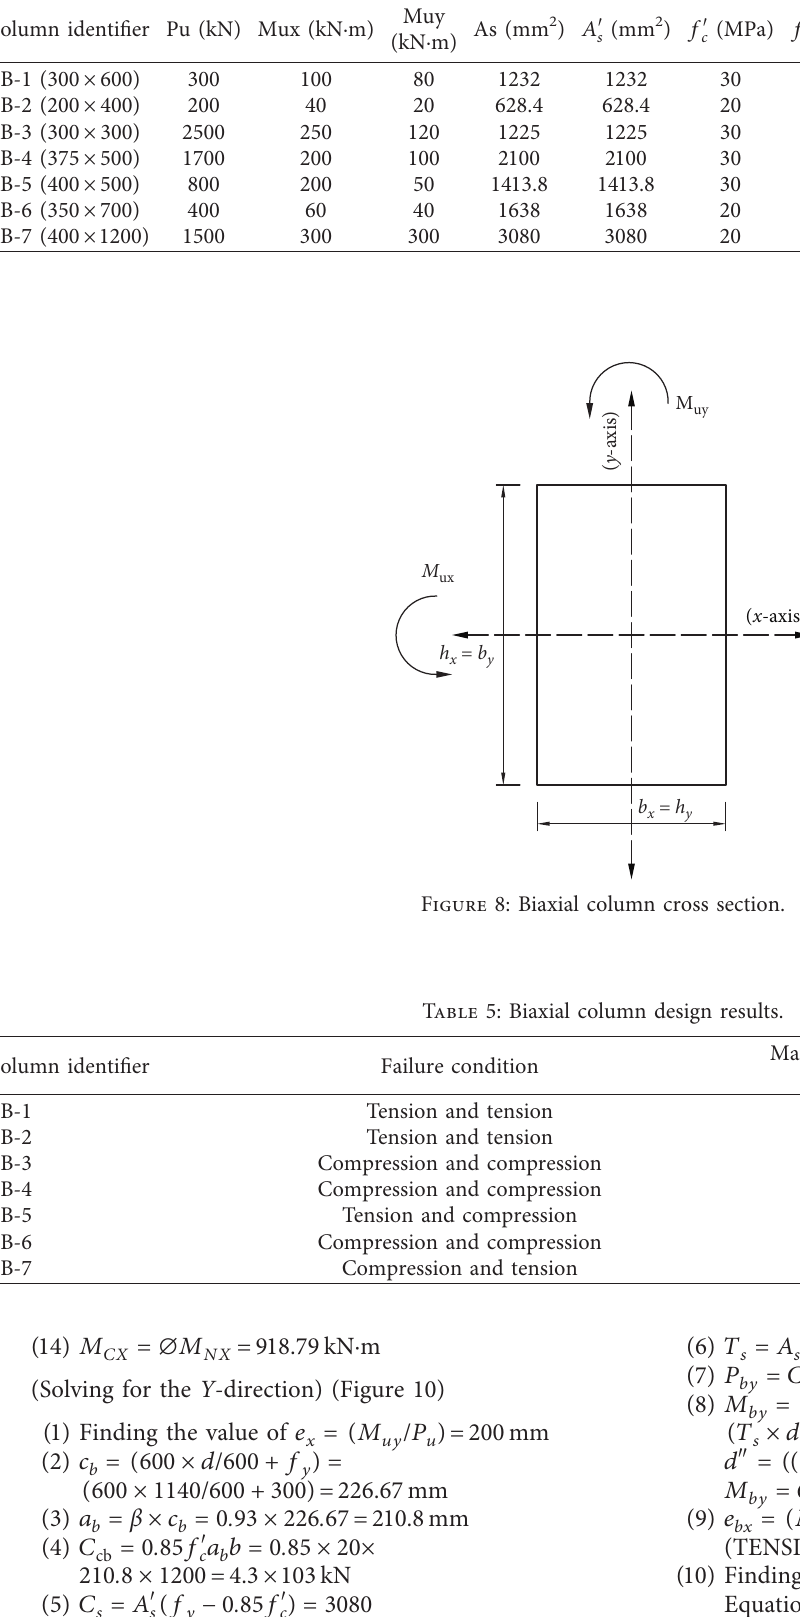
Table 4: Biaxial column input data.